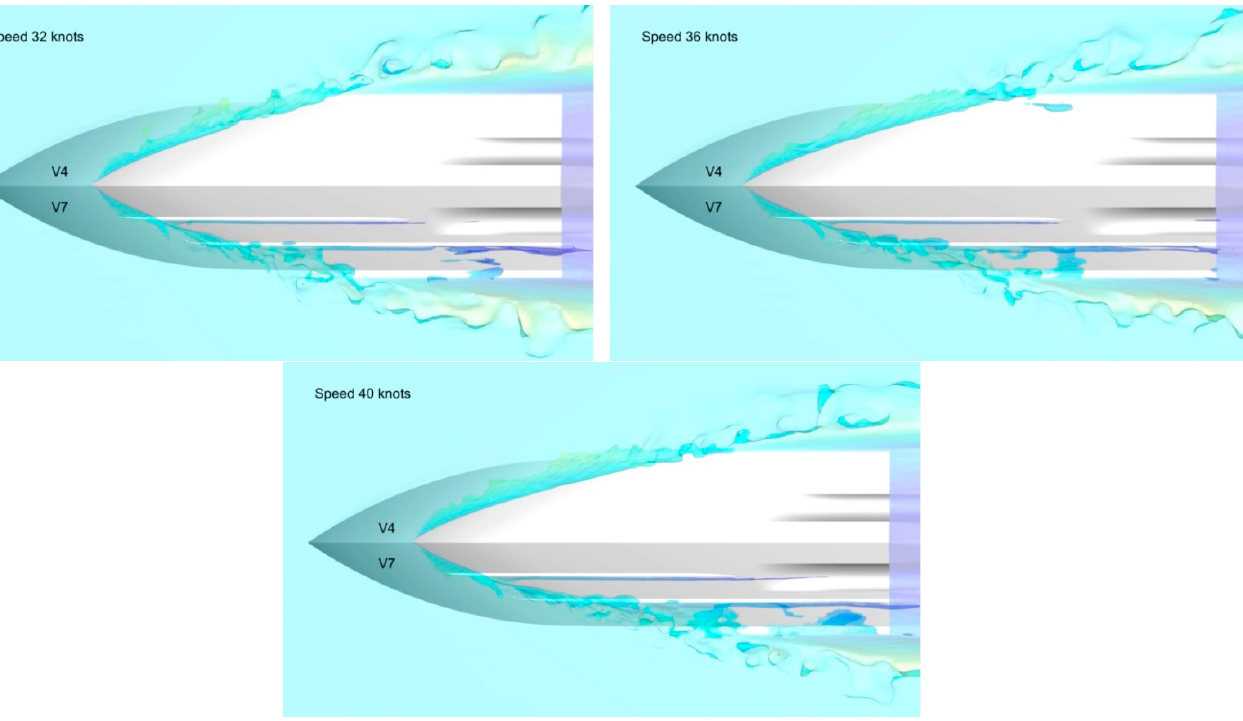
Figure 18. Comparison of free-surface and air-pocket development for V1 and V2, at 32, 36 and 40 kn.